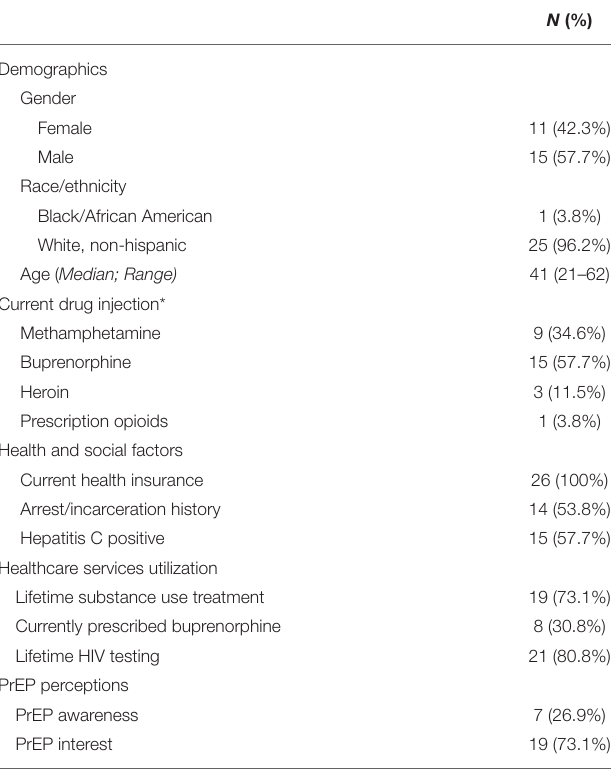
TABLE 1 | Syringe service program participant characteristics and pre-exposure prophylaxis perceptions ( N = 26).